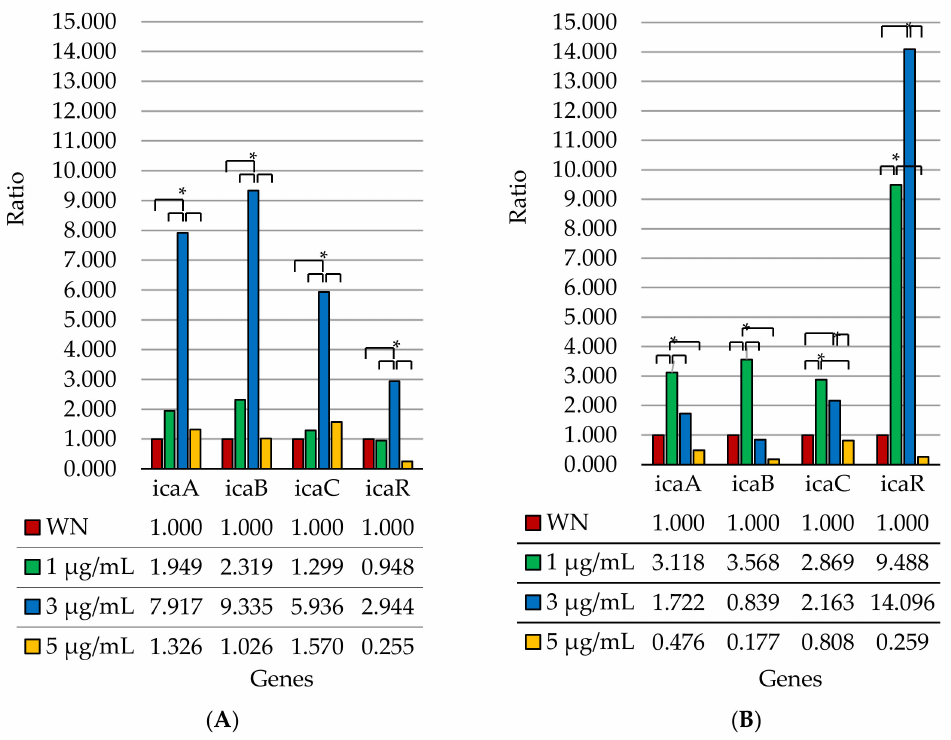
Figure 12. Expression of the genes of the icaADBC operon and the icaR gene as a ratio index, depending on the concentration of nanosilver used for the S. epidermidis ATCC 35983 strain ( A ) and for the S. epidermidis ATCC 35984 strain ( B ); WN—without nanosilver; statistical significance: * p <